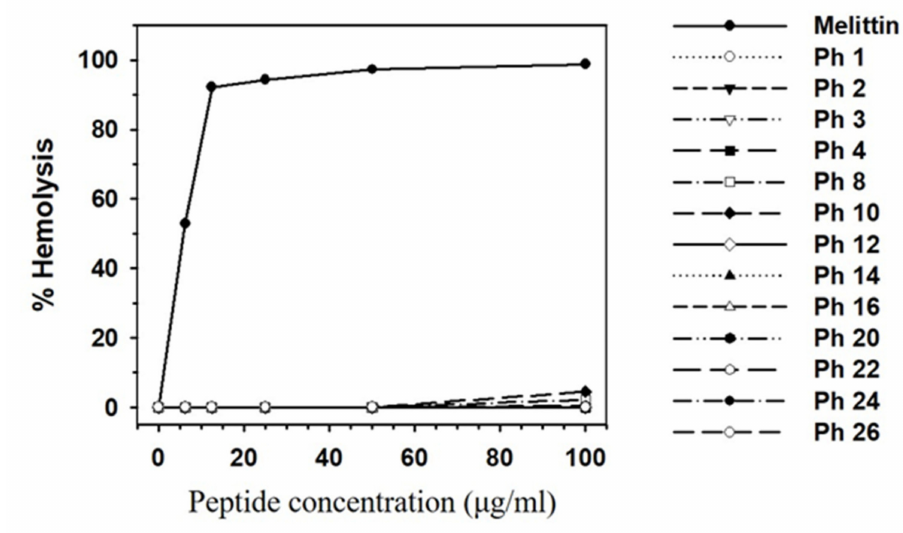
Figure 4. Cytotoxic e ff ects of 13 selected peptides. Hemolytic activity of the peptides. Peptide concentration ( x -axis) is plotted against the percentage of hemolysis ( y -axis) of mouse red blood cells after incubation for 30 min. Melittin was used as the positive control. The percent hemolysis was calculated with the following equation: hemolysis (%) = (A540 of samp—A540 of peptide-free control) / (A540 of 100% control—A540 of peptide-free control) × 100. Each symbol represents the mean value estimated from triplicate